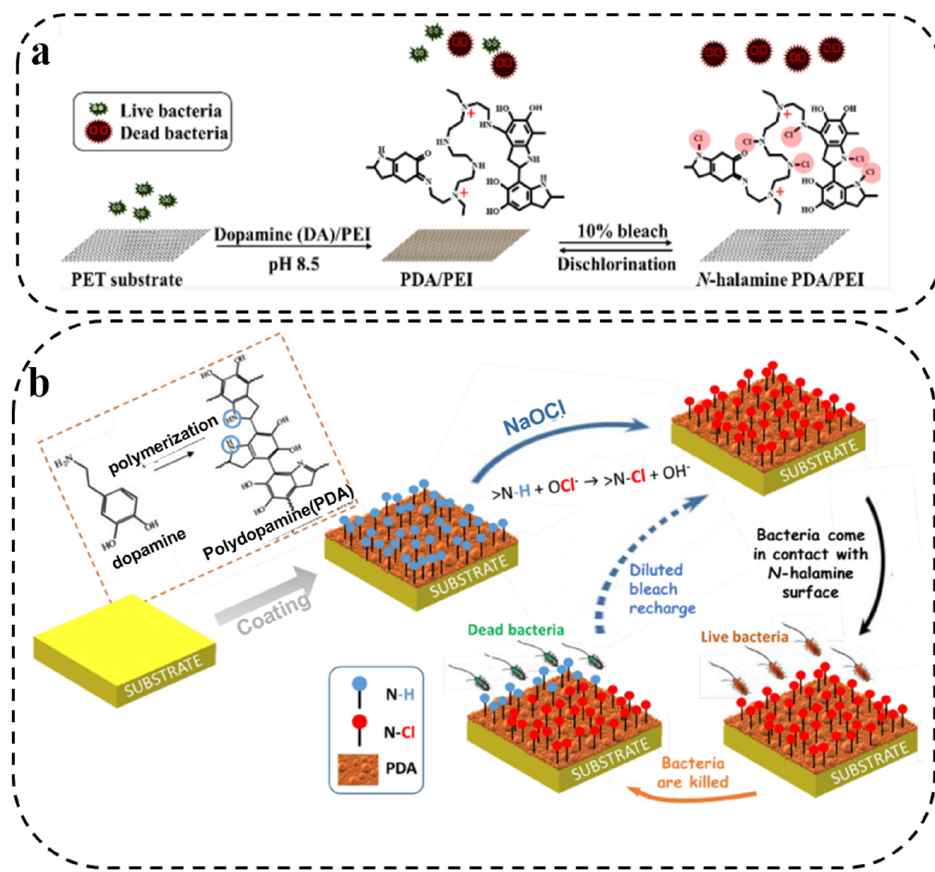
Figure 3. ( a ) Illustration of the chlorination of a co-deposited PDA/PEI. Reprinted with permission from [65] (copyright: American Chemical Society, 2021). ( b ) Schematic representation of the general strategy of formation and regeneration of an N-halamine coating based on polydopamine. Reprinted with permission from [66] (copyright: American Chemical Society, 2020).